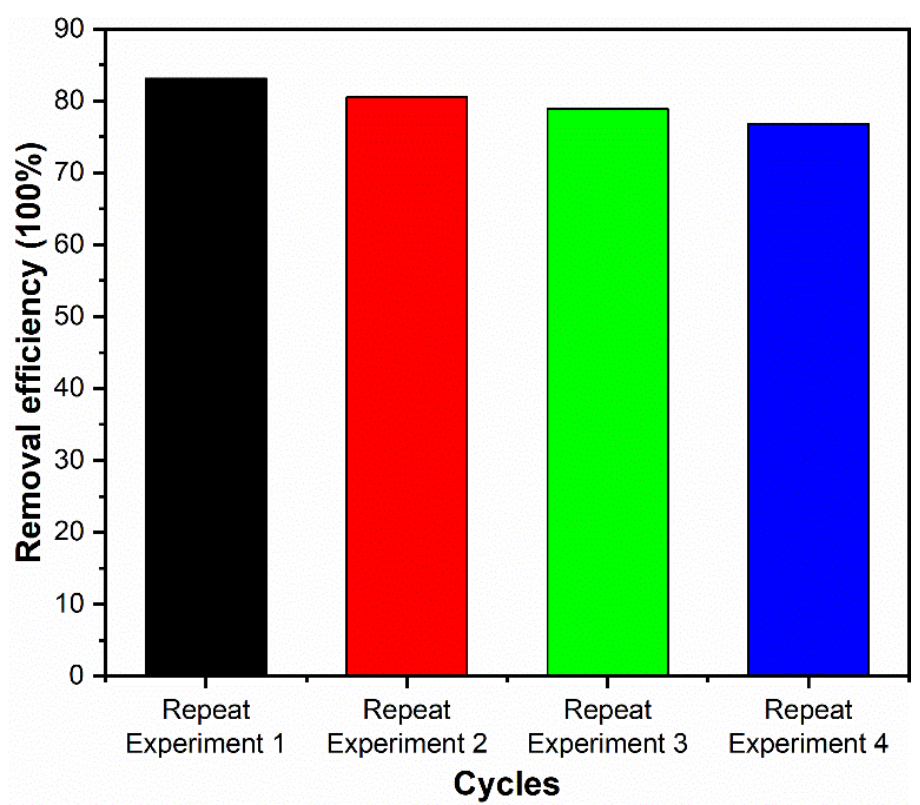
Figure 11. The cyclability of the Ag@SnO 2 /TiO 2 photocatalyst for TC degradation. The XRD pattern of the Ag@SnO 2 /TiO 2 composite photocatalyst after four cycles is shown in Figure 12. Compared with the initial sample, the positions of the diffraction peak do not change; however, the peak intensity decreases slightly. During the photocatalytic experiment, a very small amount of undegraded TC molecules may remain on the surface of photocatalyst, which decreases the diffraction peak intensity. On the other hand, the undegraded TC molecules occupy the active sites, resulting in a weak photocatalytic activity decrease [52,56,57]. This is also consistent with the repeated use experimental